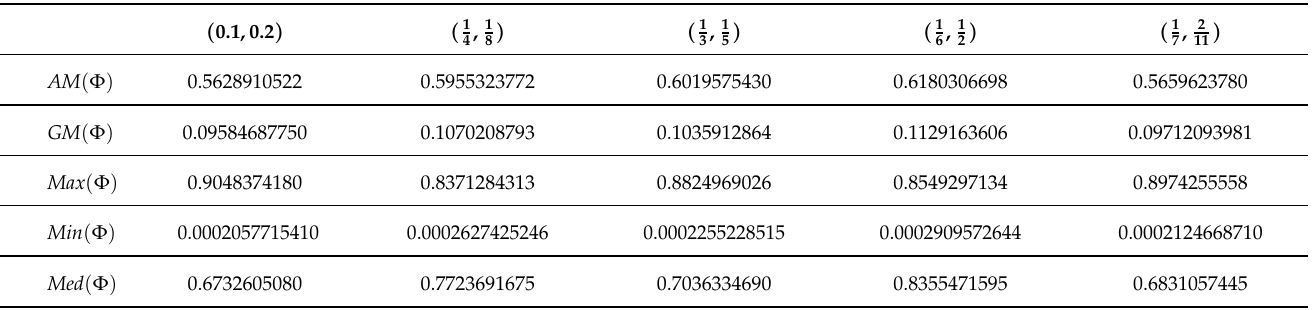
Table 2. The values of the aggregation